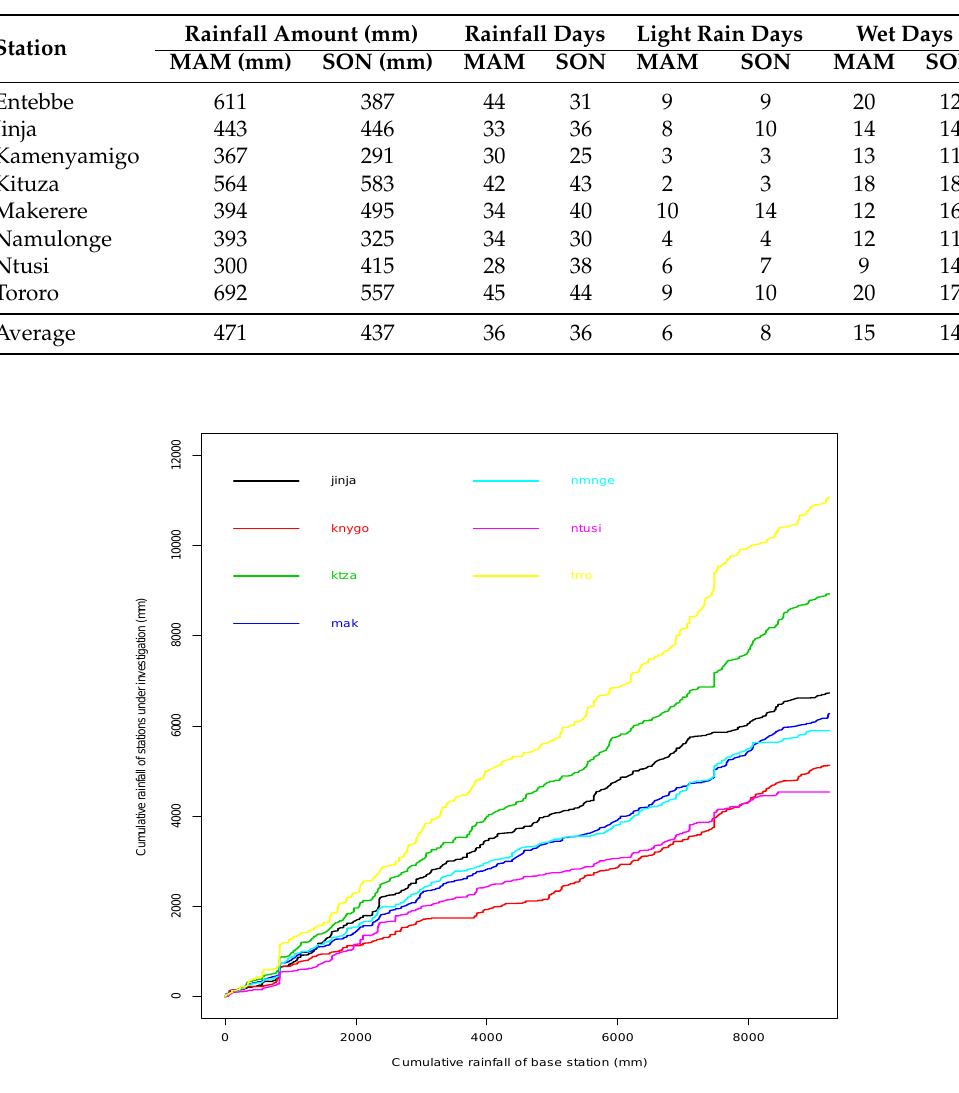
Figure 2. Double-mass curves for the study areas in reference to Entebbe station. Table 2. Shapiro–Wilk statistic ( w ) for